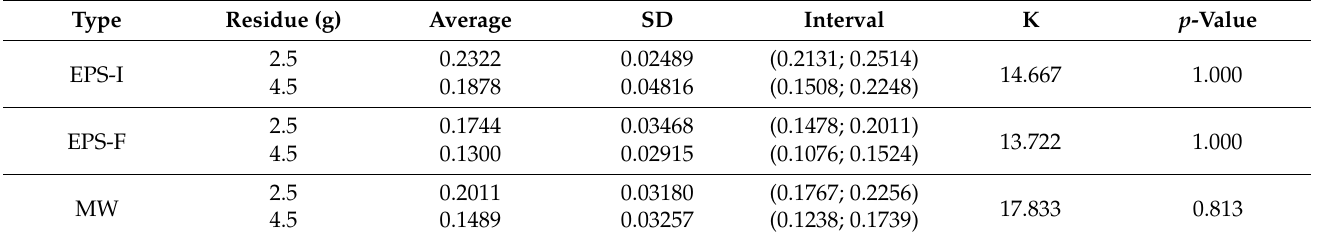
Table 10. Comparison for the adherence (MPa) in the different mortars with the incorporation of